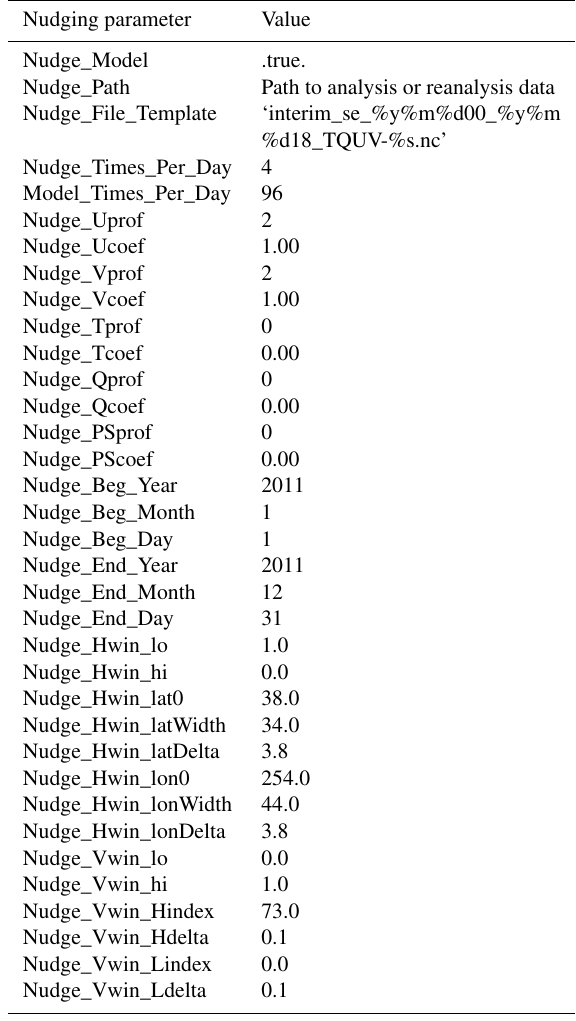
Figure 17. Nudging coefficient map zoom-in over North America. A coefficient of 0 indicates that no nudging is applied. The magenta box marks the area of the Hovmöller plots in Fig. 18. Table 3. Nudging parameter settings for the non-US nudging simu-